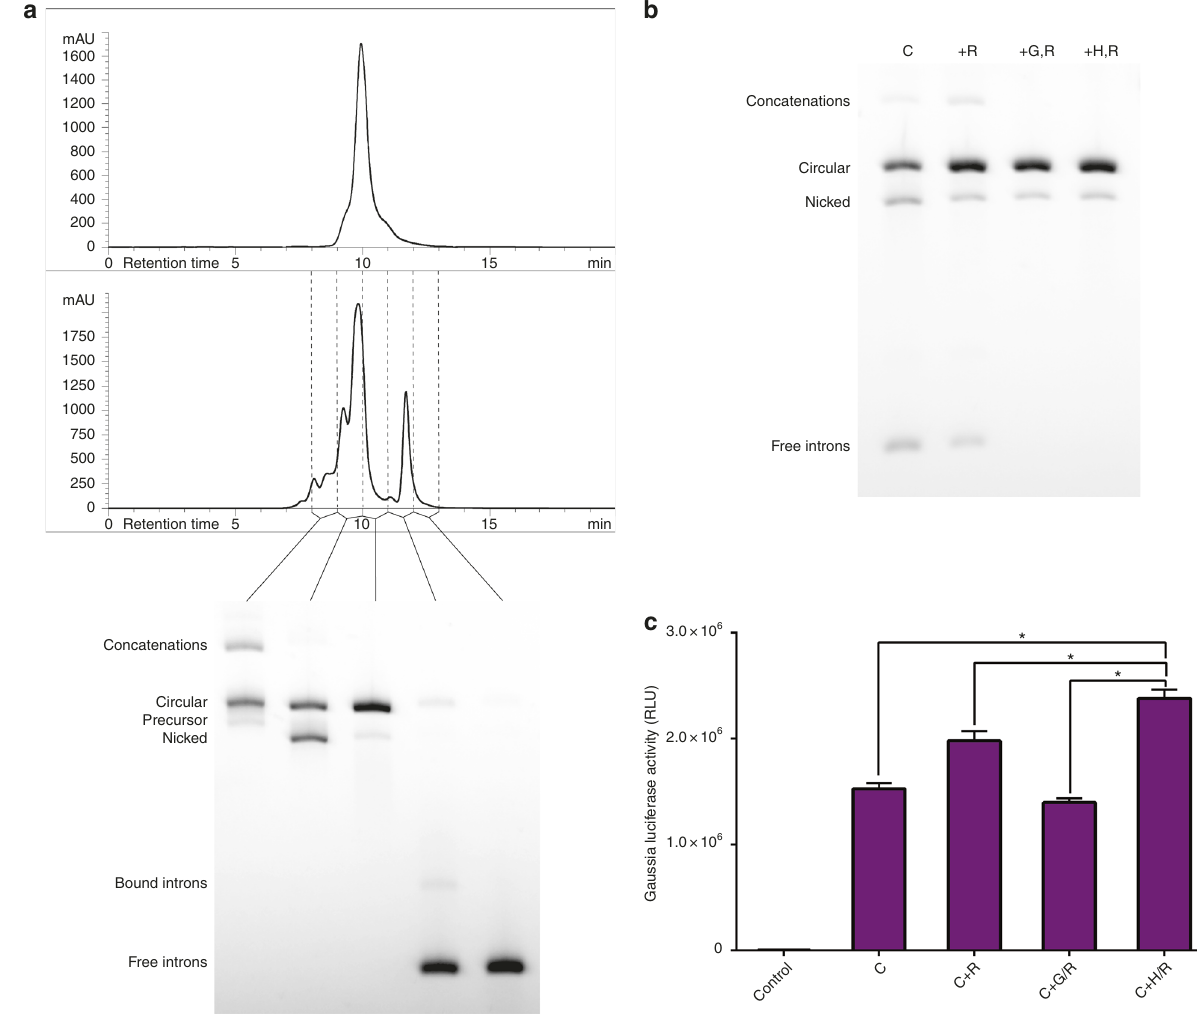
Fig. 5 HPLC puri fi cation of circRNA from splicing reactions. a HPLC chromatogram of linear GLuc RNA (top) and a CVB3-GLuc-pAC splicing reaction (middle). Agarose gel of collected fractions (bottom). b Agarose gel of CVB3-GLuc-pAC puri fi ed by different methods. C: splicing reaction. + R: splicing reaction treated with RNase R. + G,R: splicing reaction gel extracted, and then treated with RNase R. + H,R: splicing reaction HPLC puri fi ed, and then treated with RNase R. c Luminescence in the supernatant of HEK293 cells 24 h after transfection with the CVB3-GLuc-pAC splicing reactions puri fi ed by different methods as noted in ( b ) (data presented as mean + SD, n = 4, * p < 0.05 (Welch ’ s t autohydrolysis 27 , signi fi cantly reduces yields and is another intron-based system described herein permits the circularization de fi ciency that requires improvement. Longer circRNAs have more opportunities to auto-hydrolyze simply based on their size. of sequences up to 5 kb in length, signi fi cantly longer than pre- This degradation is more evident for circRNA than it is for linear viously reported. Moreover, we are able to obtain nearly 100% RNA because single nicks in circRNA manifest as a single band circularization ef fi ciency for a range of inserted coding regions on a gel, whereas single nicks in linear RNA manifest as a smear with diverse sequence compositions. We show that optimized that is diluted over a range of molecular weights. This phenom- enon is visible in Fig. 3b, lane 7 (FLuc, R-, as well as several other lanes); two major bands exist in this lane, with the top major band representing intact circRNA while the bottom major band protein for a longer duration than the unmodi fi ed and modi fi ed represents nicked circRNA. No smear extends from the intact circRNA band, while a smear extends from the nicked circRNA holds potential as an alternative to mRNA for the stable band. The nicked circRNA band represents single nicks that occur at random positions in an intact circRNA, while the smear fully investigate the potential of circRNA for therapeutic and that extends from it represents additional nicks beyond the fi rst that occur at random positions in the linearized nicked circRNA protein translation from circRNA and a comprehensive study of and thus give rise to degradation products of varying molecular the translation ef fi ciency and stability of circRNA in other cell weights. We do not expect circRNA nicking to present challenges types and tissues. The nicking of longer circRNAs that we beyond those that already exist for maintaining the stability of observed during the production of circRNA (Supplementary linear RNA in solution and during processing. 2a), likely mediated by magnesium-catalyzed